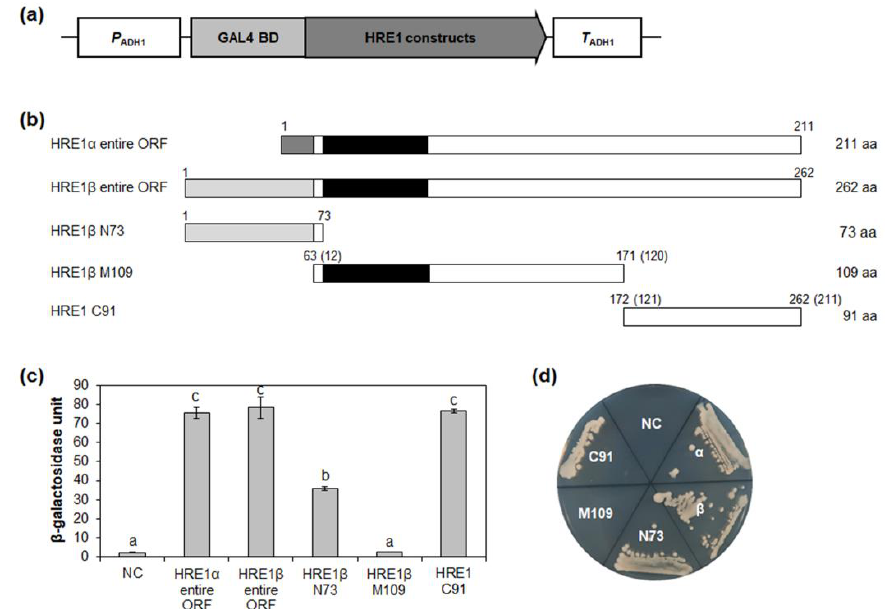
Figure 3. Analysis of transactivation activities of HRE1 α and HRE1 β . ( a ) The schematic map of the vector for analysis of transactivation activities of full-length ORFs of HRE1 α and HRE1 β , and truncated fragments of HRE1 β in yeast. ( b ) The schematic maps of full-length ORFs of HRE1 α and HRE1 β , and truncated fragments of HRE1 β for the analysis of transactivation activity in yeast. The numbers in parentheses represent the position in HRE1 α . ( c ) Quantitative β -galactosidase ONPG assay. The transactivation activities were quantified by measuring the β -galactosidase activity in yeast extract. The experiments of each technical replicate were performed in triplicate. The data shown are the means ± S.D. ( n = 3). Similar results were obtained from at least three biological replicates, with one shown here. The data were analyzed with one-way ANOVA using Tukey’s multiple comparison